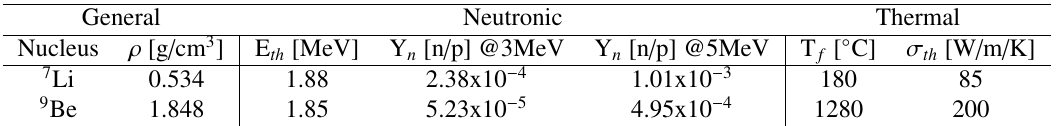
Table 1: Neutronic and thermal properties for di ff erent material foreseen as a target. The neutron yields are from [3].